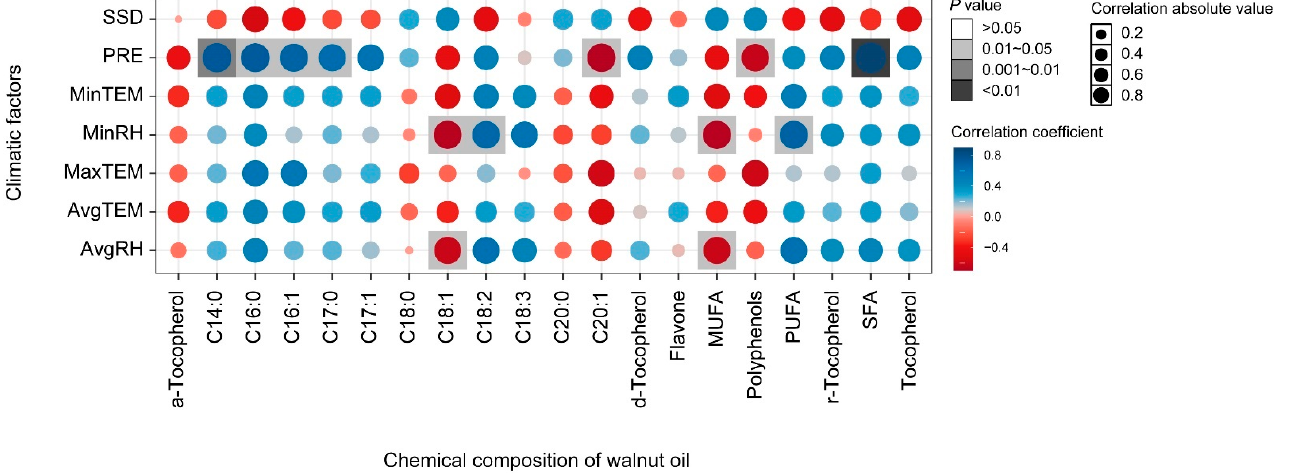
Figure 5. Correlation analyses of the climatic factors and chemical composition of walnut oil. Note: MinRH, minimum relative humidity (%); AvgRH, average relative humidity (%); AvgTEM, average temperature (°C); MaxTEM, maximum temperature (°C); MinTEM, minimum temperature (°C); PRE, precipitation (mm); SSD, sunshine duration (h); the same as below.